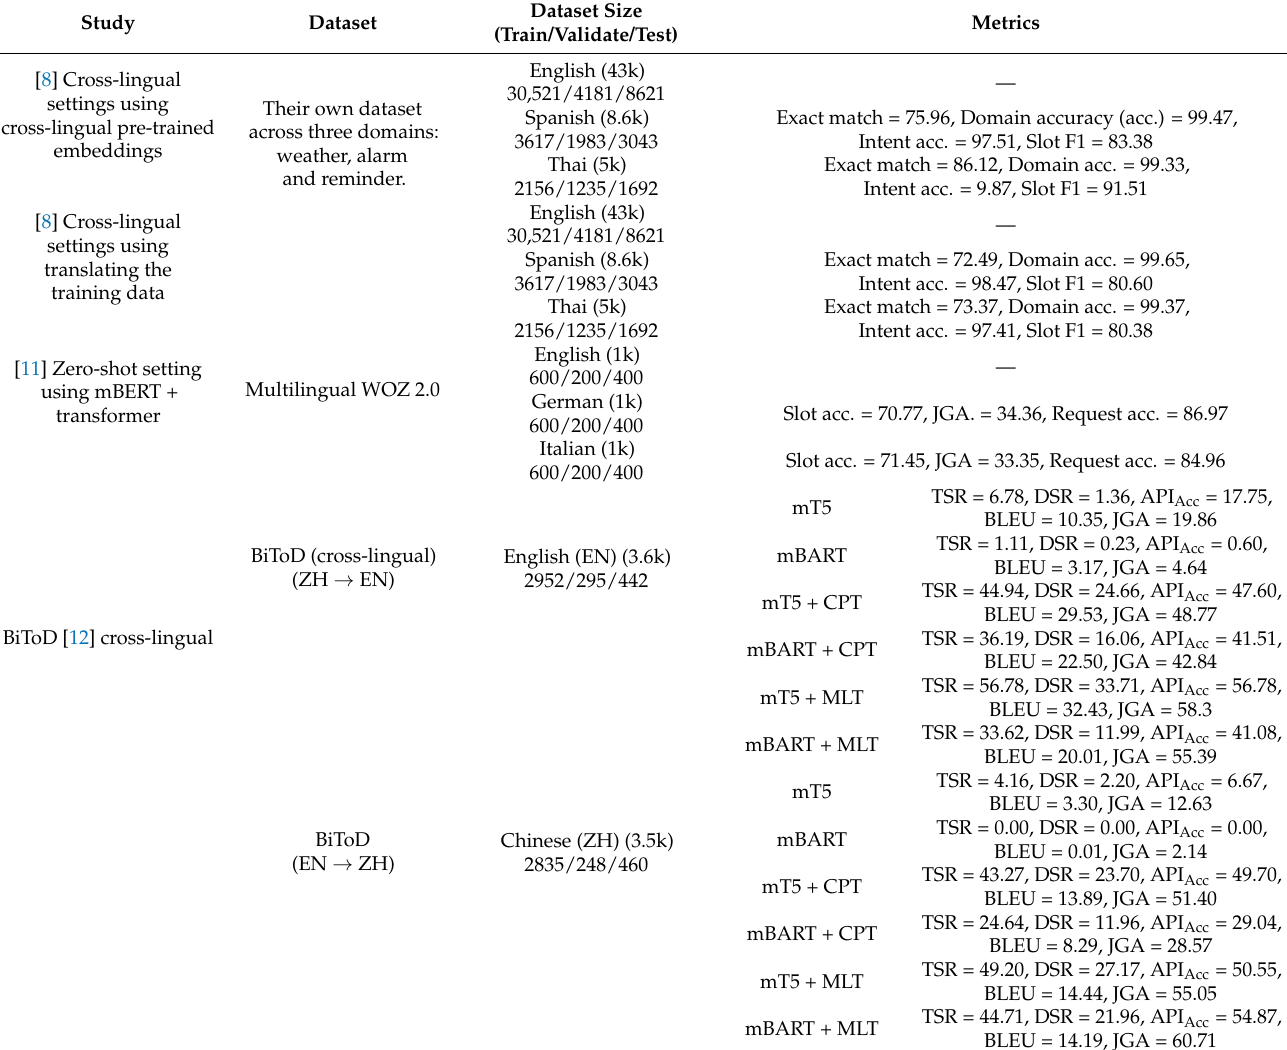
Table 1. Performance comparison of the most common state-of-the-art multilingual models in task-oriented dialogue systems (DS) for cross-lingual